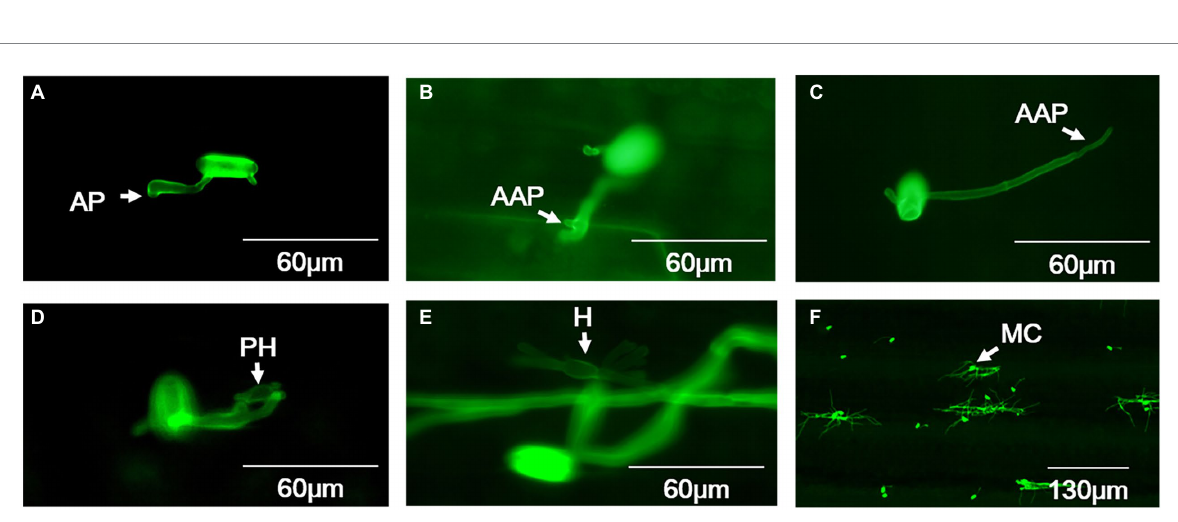
FIGURE 2 Histological observation on key infection stages of B. graminis f. sp. tritici isolates at 18 ° C. (A) Appressorium, (B,C) Abnormal appressoria, (D) Primary haustoria, (E) Finger-like matured haustoria, (F) Microcolony. AP = appressorium; AAP = abnormal appressorium; PH = primary haustorium; H = haustorium; MC = microcolony. A-E bars=60µm, F